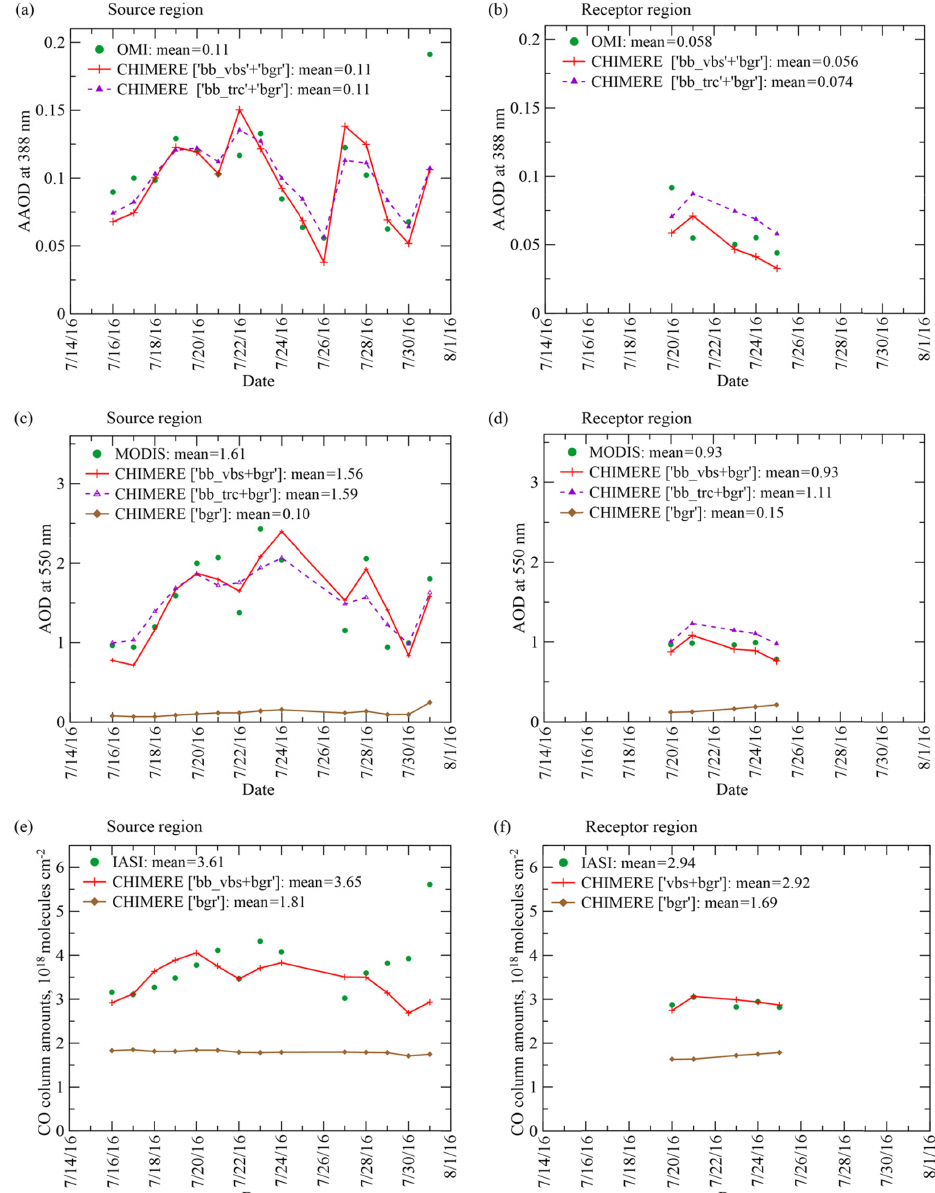
Figure 4. Time series of the daily (a, b) AAOD, (c, d) AOD, and (e, f) CO values averaged over the study region according to the satellite observations and the CHIMERE simulations under the different model scenarios for the (a, c, e) source and (b, d, f) receptor regions indicated in Fig. 2. All the data were selected consistently. Note that the simulations for the bgr (background) scenario are shown after applying the de-biasing procedure (see Sect. 2.5). The background AAOD is not evaluated in this study and therefore not shown. Taking into account that the time series are very short, the correlation coefficient has not been evaluated (as its values are not sufficiently